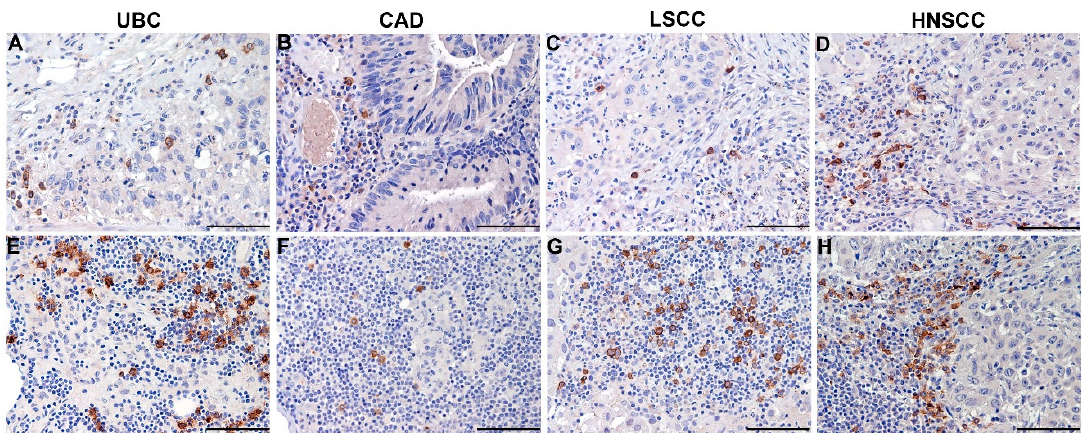
Figure 3. pDCs infiltration in primary carcinomas and carcinoma-draining lymph nodes. FFPE sections are from representative carcinoma cases from different primary sites (top row) and corresponding draining lymph nodes (bottom row). Matched images are from urothelial bladder cancer (UBC; A , E ), colon-rectal adenocarcinomas (CAD; B , F ), lung squamous cells carcinoma (LSCC; C , G ) and head and neck squamous-cells carcinoma (HNSCC; D , H ). Staining has been performed with BDCA-2 (clone 124B3.13, 1:75, Dendritics) and revealed using Novolink Polymer (Leica Microsystems) followed by 3,3 ′ -diaminobenzidine (DAB) as chromogen. pDC infiltration is observed at the primary carcinoma sites ( A–D ) and is very dense in lymph node metastasis ( E–H ) suggesting that this rare cell subset can be found in a wide spectrum of solid tumors and corresponding draining lymph nodes. Magnification 200× (scale bar 100 µm).